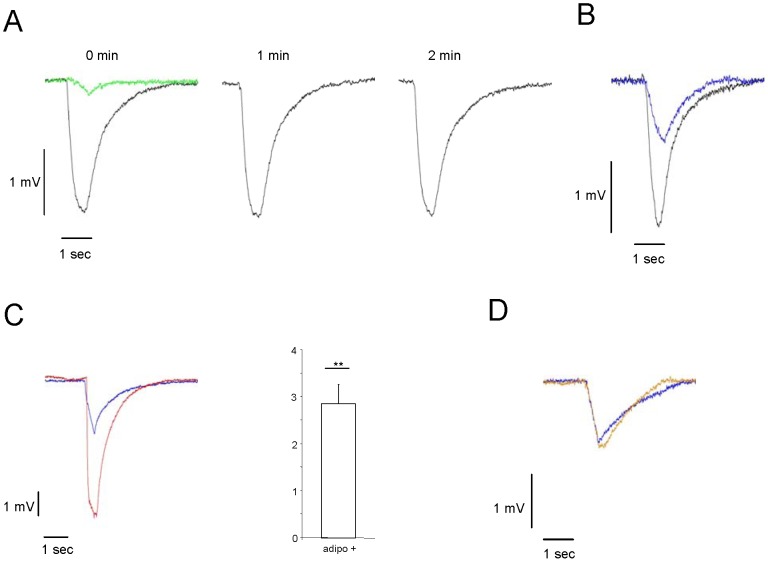
Adiponectin increases the electrical response of olfactory sensory neurons to benzaldehyde.(A) Representative EOG responses to benzaldehyde (1:1000) (black traces) recorded from one position on the medial surface of endoturbinate II at 1 min intervals. Air puffs without odorant resulted in very small response amplitudes (green trace). (B) Representative EOG responses to benzaldehyde (1∶1000, black trace; 1:100.000, blue trace) recorded at one position on the medial surface of endoturbinate II. (C) Representative EOG response to benzaldehyde (1∶100.000) recorded at the medial surface of endoturbinate II; traces recorded 5 min before adiponectin application are shown in blue, those recorded 15 min after adiponectin application to that site are shown in red. Graph shows average fold-change after preincubation with adiponectin. Amplitude values before adiponectin application were set as 1. Adiponectin application leads to a 2,8-fold enhancement in EOG responses (EOG values before adiponectin application  =  1; adipo+: 2.86±0.4; P = 0.0012). Number is given as mean ± SD. (D) Representative EOG response to benzaldehyde (1:100.000) recorded at the medial surface of endoturbinate II; the trace recorded 5 min before application of buffer solution is shown in blue, the one recorded 15 min after buffer application to that site is shown in orange. Odorants were always applied for 500 ms. **, statistically very significant.